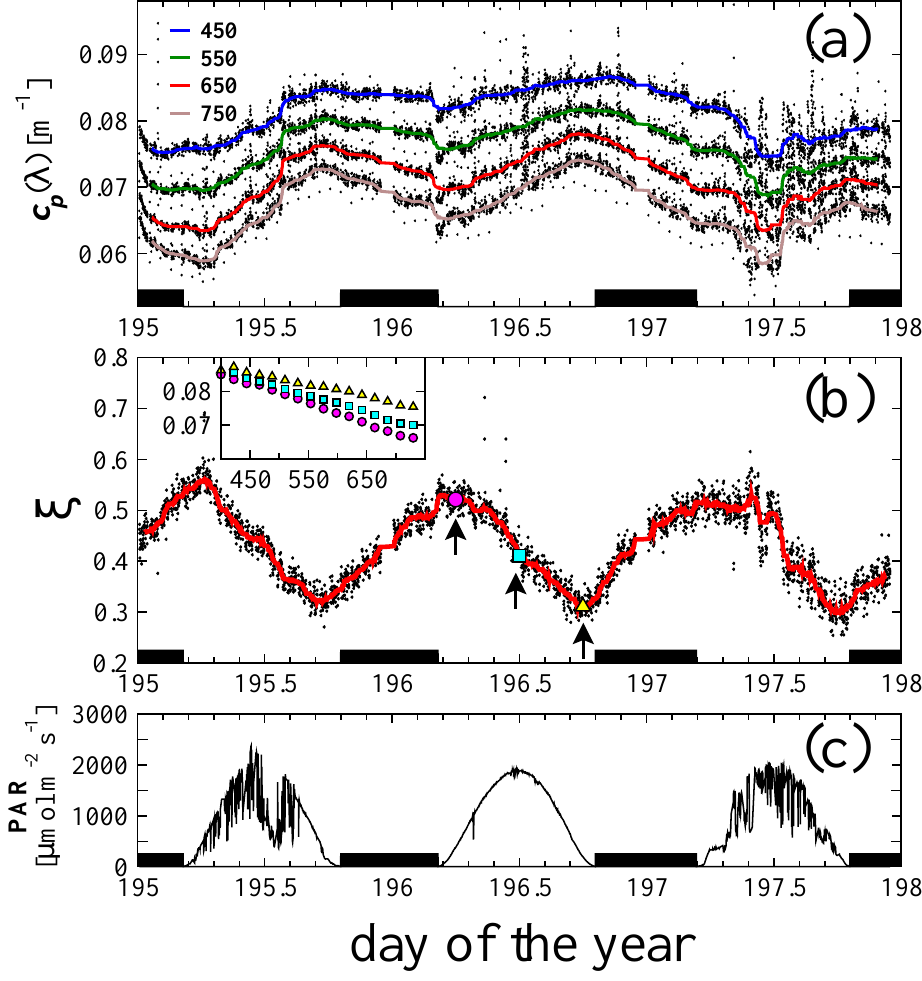
Fig. 1. Time series of data collected at the long duration station. (a) Particulate beam-attenuation coefficient at selected wavelengths. Black dots are the original data, solid lines are moving medians (2h window). (b) Spectral slope of c p computed between 550 and 750nm (spectra become steeper as ξ increases, see Eq. 1). The inset presents typical c p spectra as a function of wavelength (nm) at selected times of the day (see arrows in the ξ time series). (c) Photosynthetically available radiation.